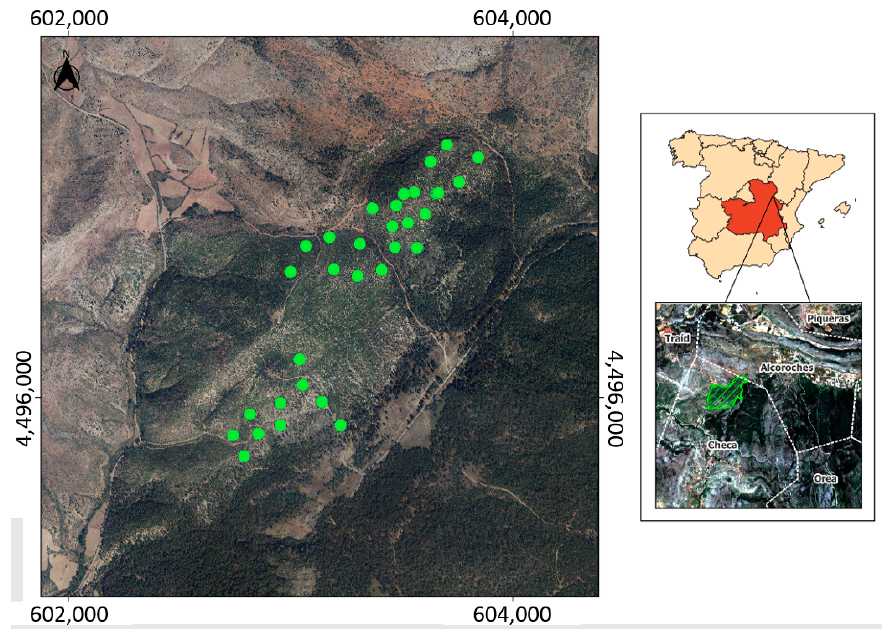
Figure 1. Study area and location of field plots to estimate shrub biomass in the burnt area (Chequilla, Spain). 2020.